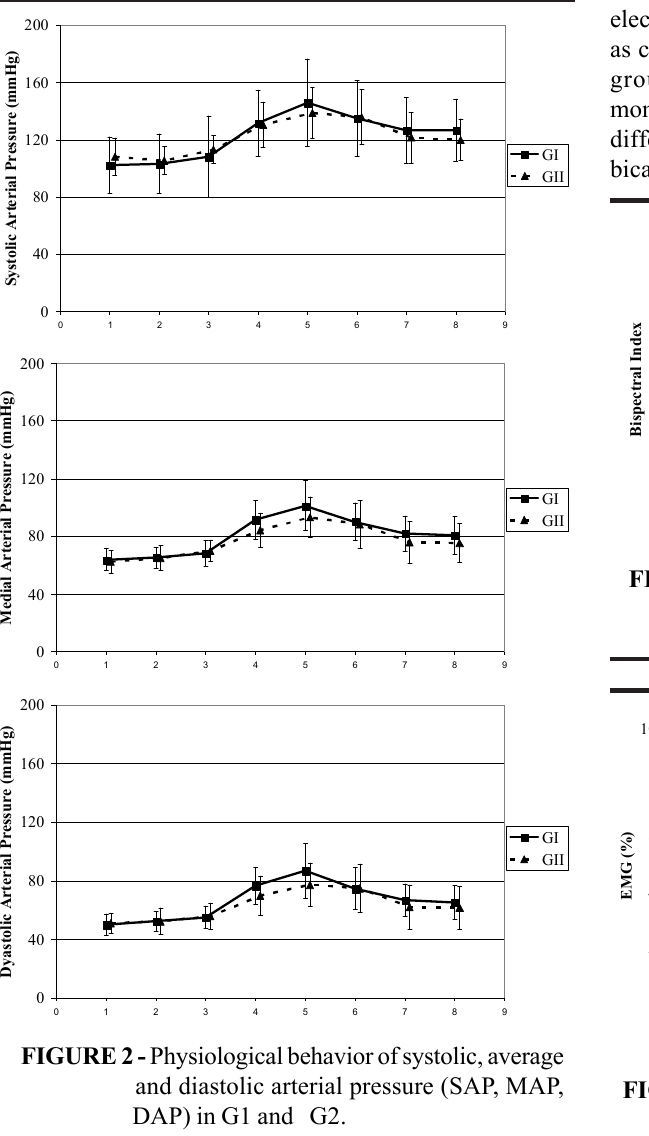
FIGURE 3 - Physiological behavior of ETCO in G1 and G2.